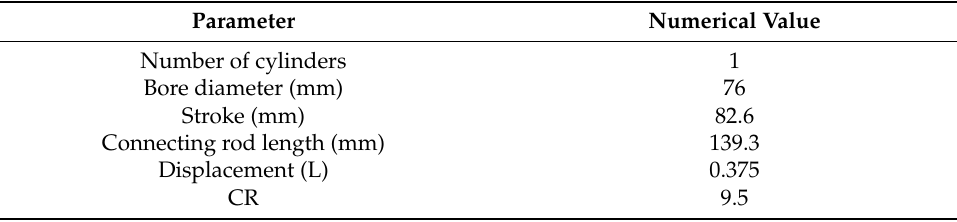
Figure 1. Geometric model of the GDI engine. Table 1. Basic parameters of the GDI engine. Table 1. Basic parameters of the GDI engine.